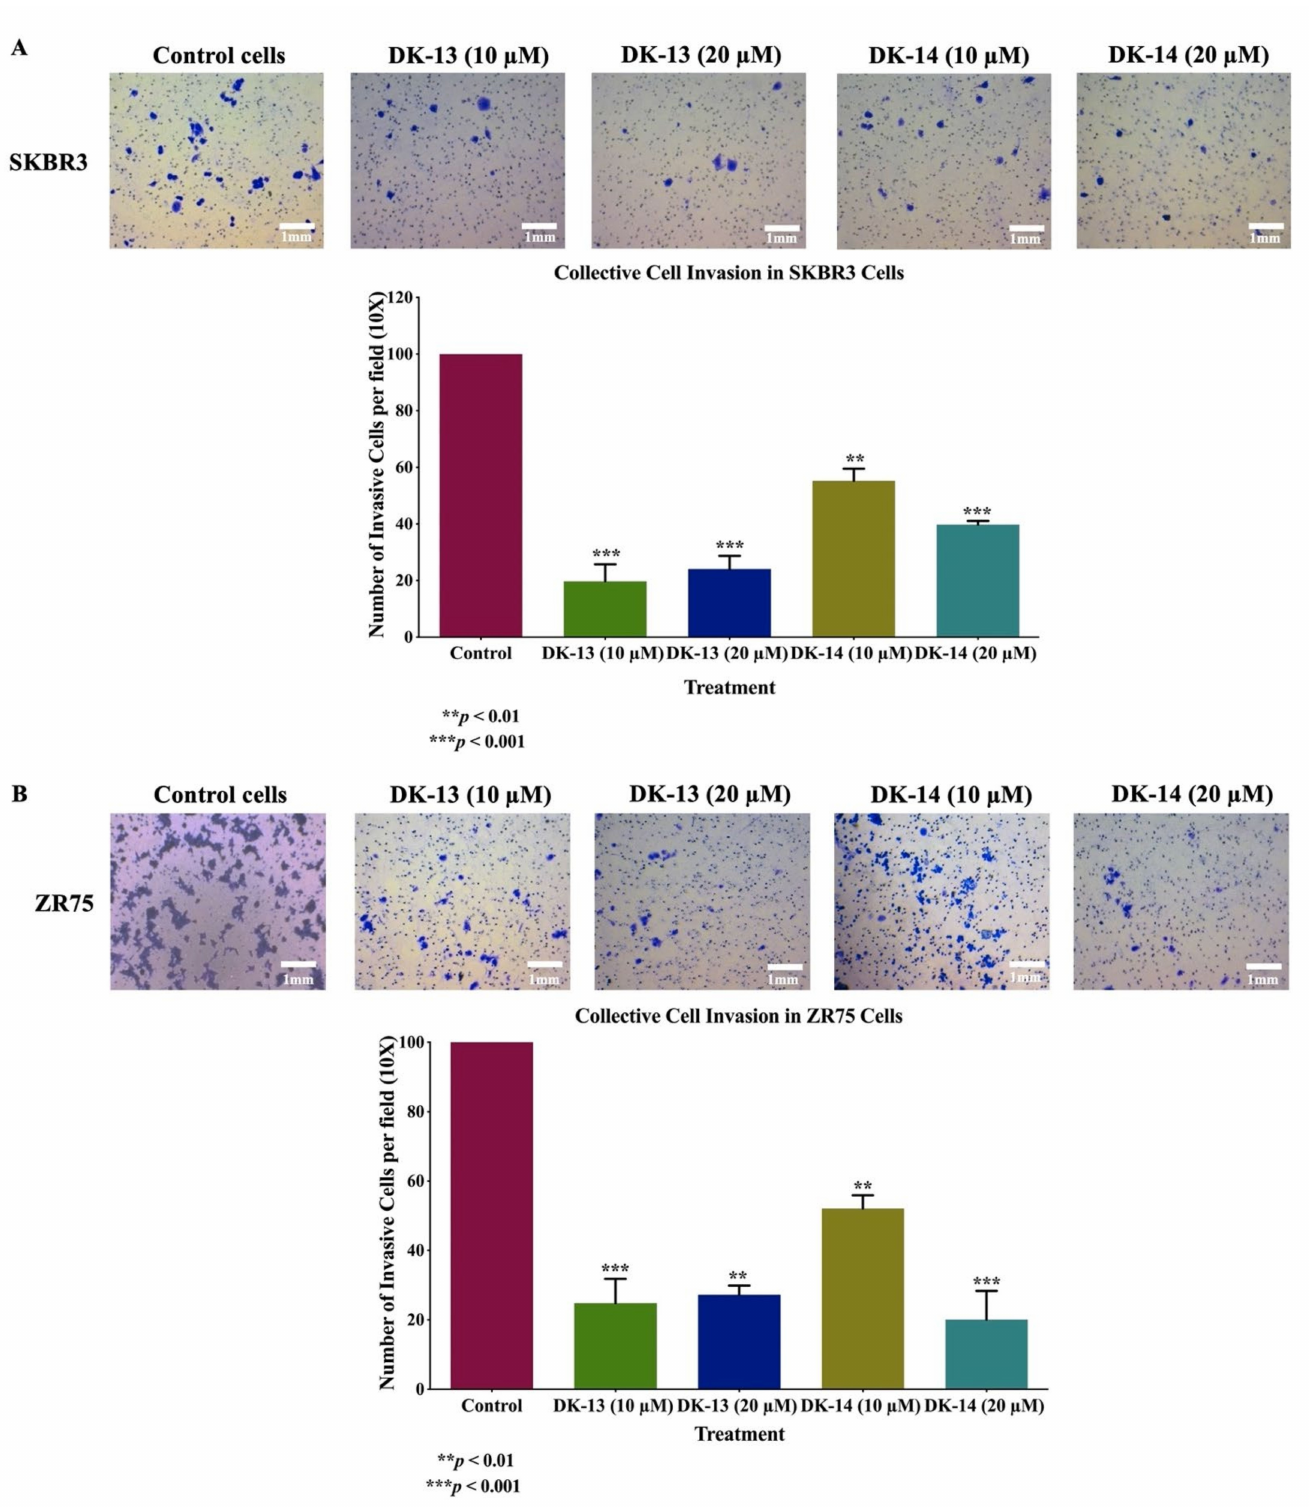
Figure 4. ( A , B ) . Effects of compounds DK-13 and -14 on cell invasion of human HER2-positive breast cancer cells. Chalcone compounds (DK-13 and -14) inhibit cell invasion ability of ( A ) SKBR3 and ( B ) ZR75 cell lines using Boyden chambers. Cancer cells treated for 48 h with 10 and 20 µ M chalcone compounds show a significant inhibition of cell invasion in both cell lines, when compared with their matched control (** p < 0.01, *** p < 0.001). Data are quantified by normalizing the number of invasive cells by their total